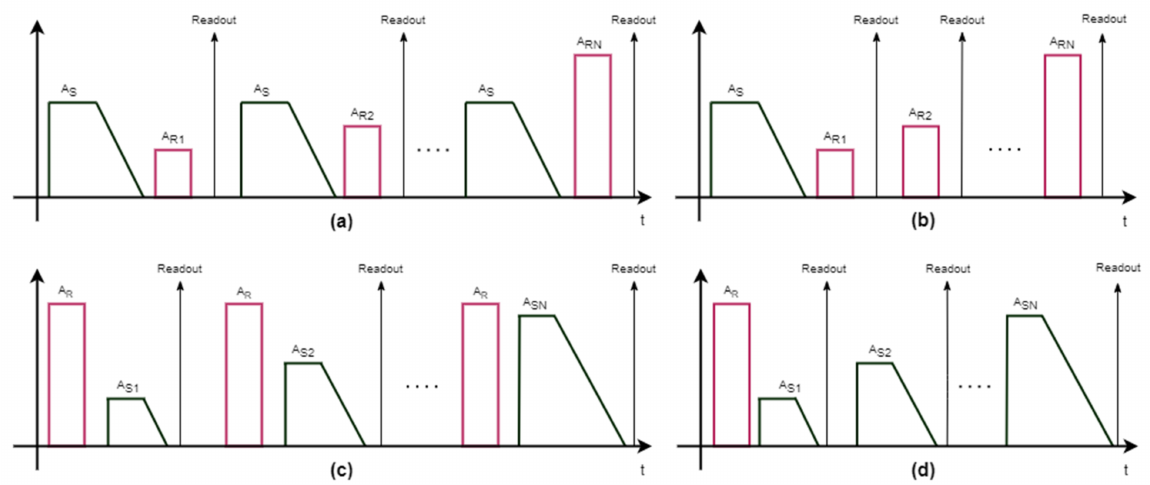
Figure 9. Analyzed programming sequences: ( a ) RESET single pulse (RSP); ( b ) RESET staircase (RSC); ( c ) SET single pulse (SSP); ( d ) SET staircase